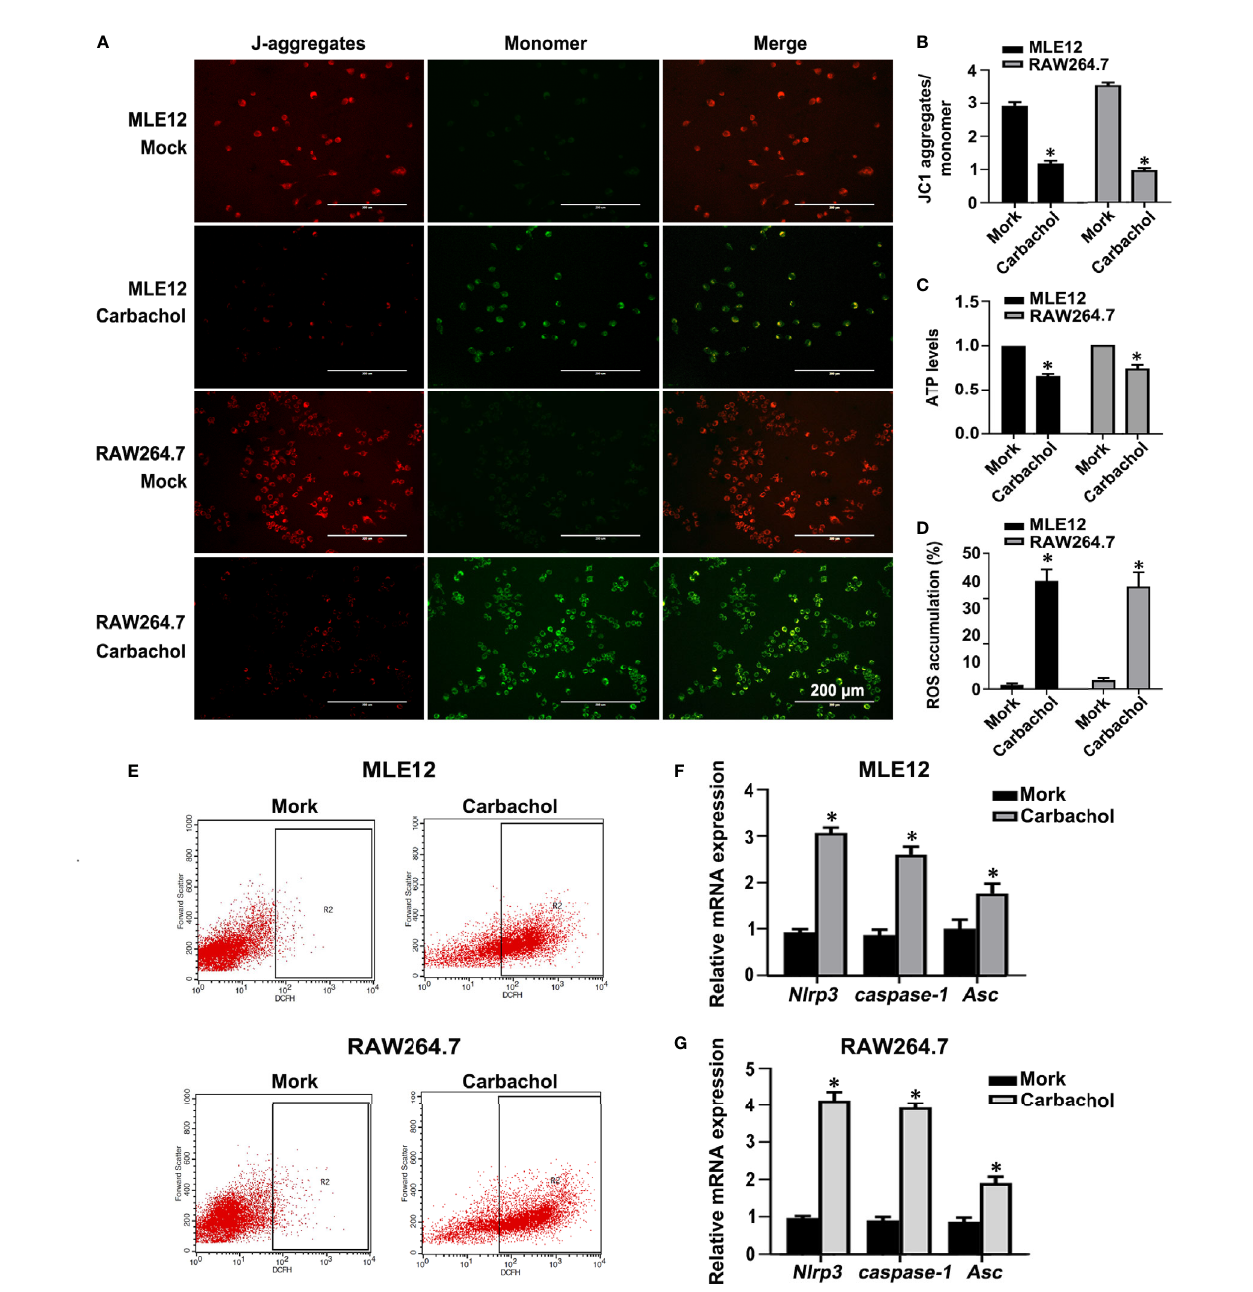
FIGURE 11 | Carbachol stimulates mitochondrial dysfunction and NLRP3 in fl ammasome activation in lung epithelial cells and macrophage. (A, B) Fluorescence microscopy and the ratio of JC-1 staining (red, J-aggregates; green, monomer) in MLE12 and RAW264.7 cells after treating with 50 m M carbachol or non-treated for 24h, Scale bar: 200 m m. (C) Levels of ATP. (D, E) Levels of ROS were determined by fl ow cytometry. (F) Levels of NLRP3, caspase-1and Asc mRNA in MLE12 cells. (G) Levels of NLRP3, caspase-1 and Asc mRNA in RAW264.7 cells. Data are expressed as means ± SD from 3 independent experiments. Mann-Whitney U test was used for caspase-1 mRNA comparison between two groups from MLE12 cells, because the data were non-normally distributed. * P < 0.05 vs . Mock